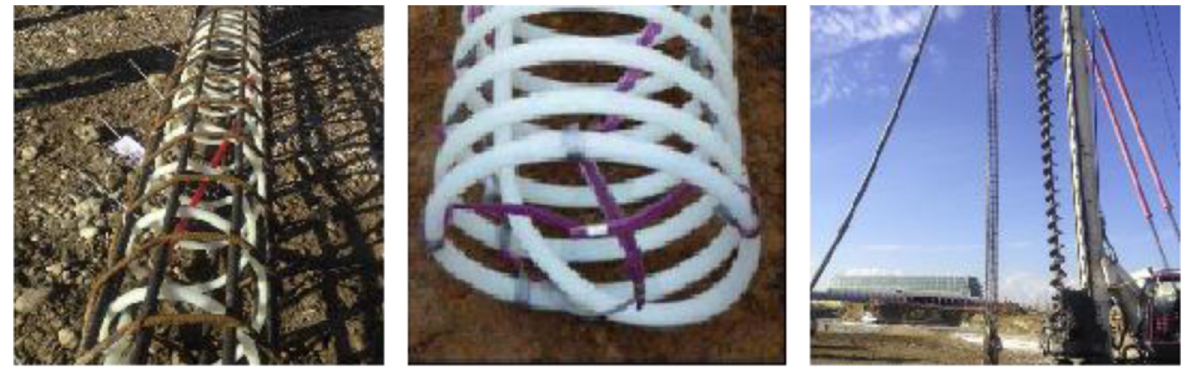
Fig. 21 Spiral borehole heat exchanger